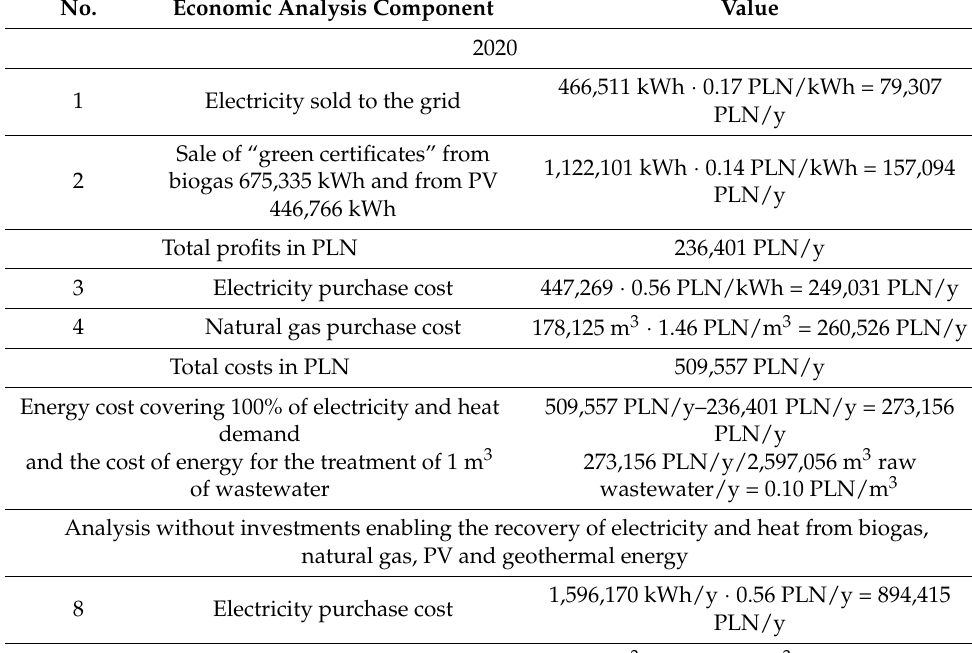
Table 3. Economic analysis of the costs of obtaining energy in WWTP Gubin–Guben. No. Economic Analysis